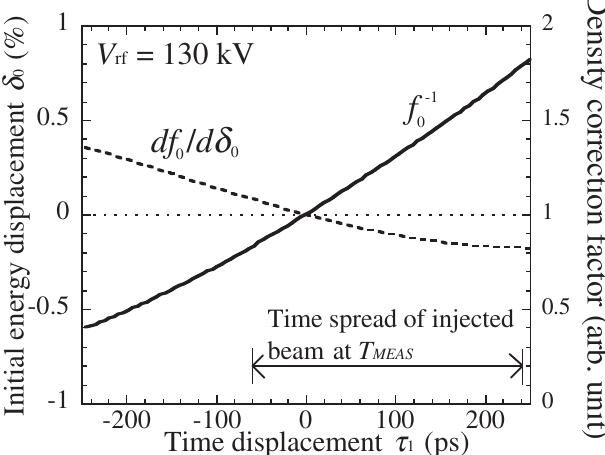
FIG. 9. Nonlinearity correction functions for the rf bucket. The , which is the initial energy solid line is the scaling function f (cid:3) 1 0 displacement (cid:3) for the calculated time displacement (cid:1) . The 0 1 broken line is the density correction function, which is the (cid:2) 0 normalized by its value at (cid:3) differential of f 0 0